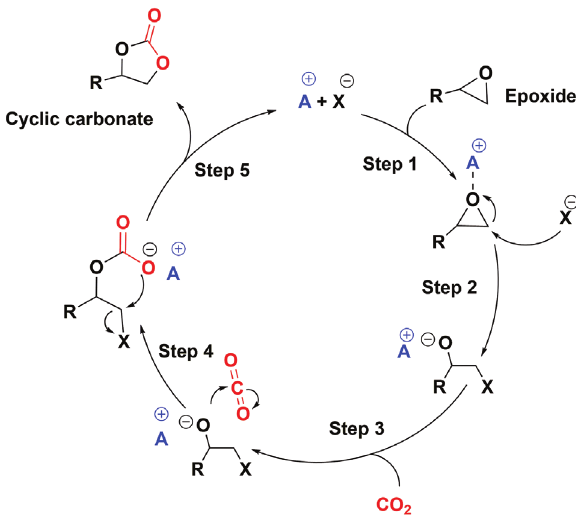
Figure 1: General mechanism of cyclic carbonate synthesis from CO and epoxide using an acid-base 2